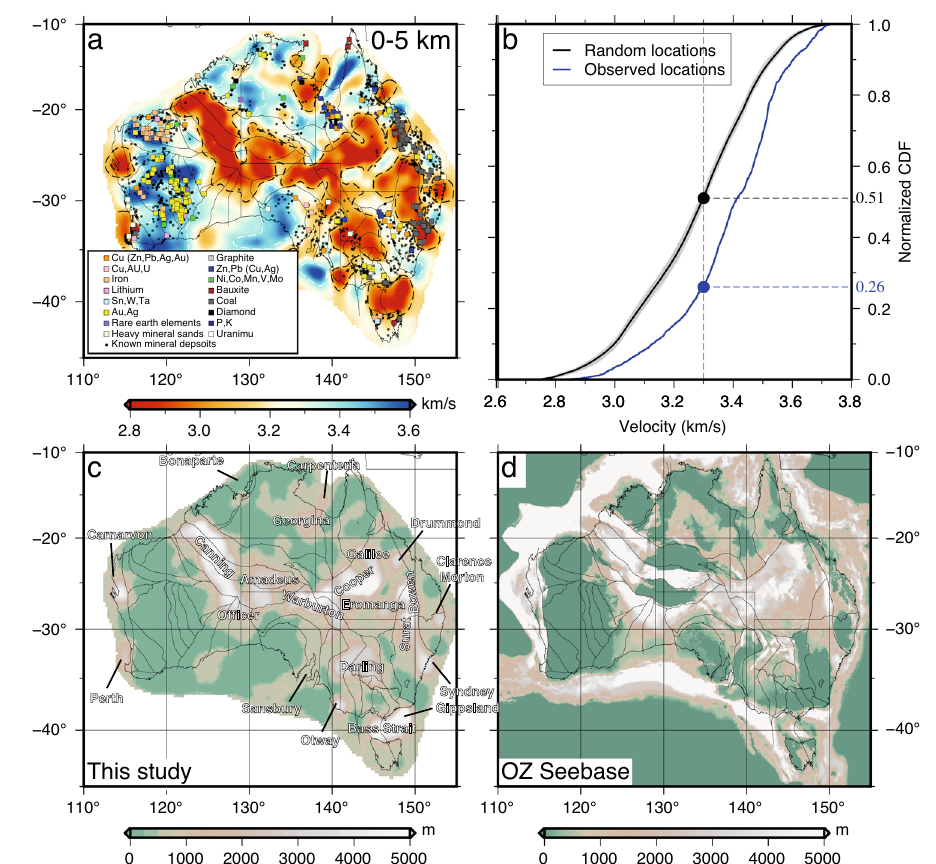
Fig. 7 | Sedimentary basin structure. a Average shear velocities between 0 and 5km depths. The squares indicate the locations of operating mines 49 . The black circles indicate the locations of known mineral deposits. The white and black dashed lines highlight high and low velocity contours of 3.6km/s and 3.3km/s, respectively. b Normalized cumulative density function (CDF) of seismic velocities sampledatlocationsofmineraldepositsinthedepthrangeof0 – 5km.Theblueline indicates the CDF calculated according to the observed mineral locations. The